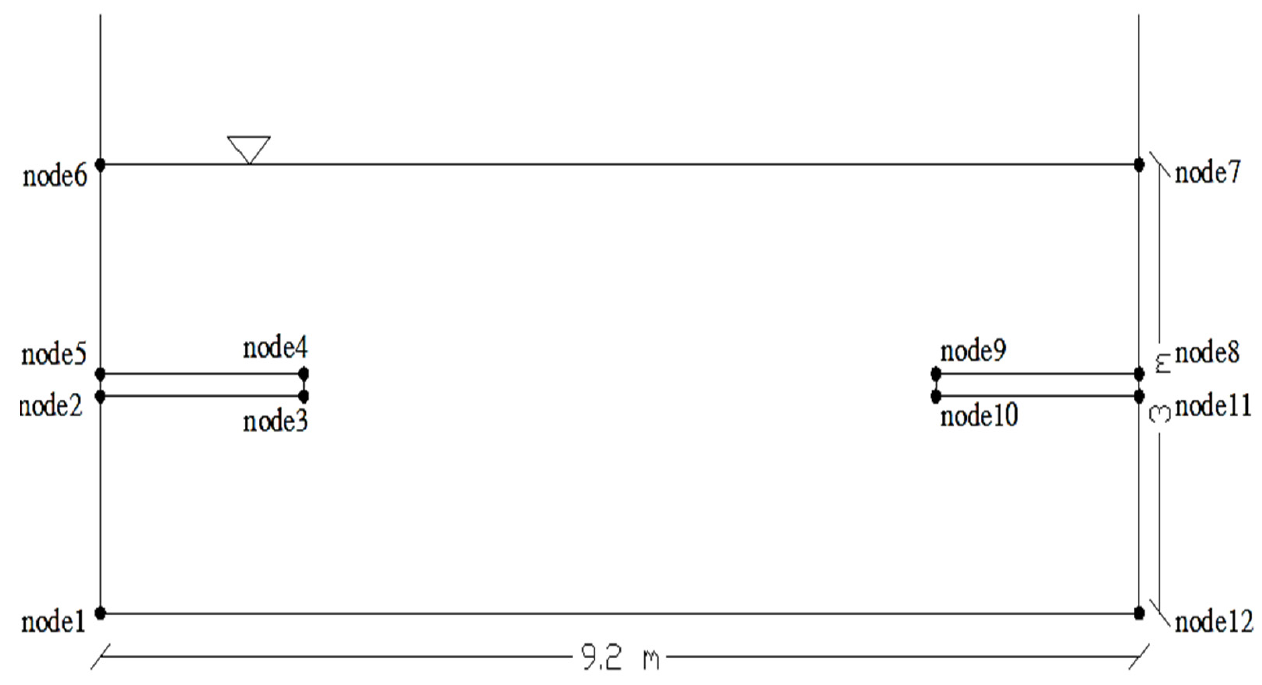
Figure 6. Cross-section of the tank equipped with baffles.